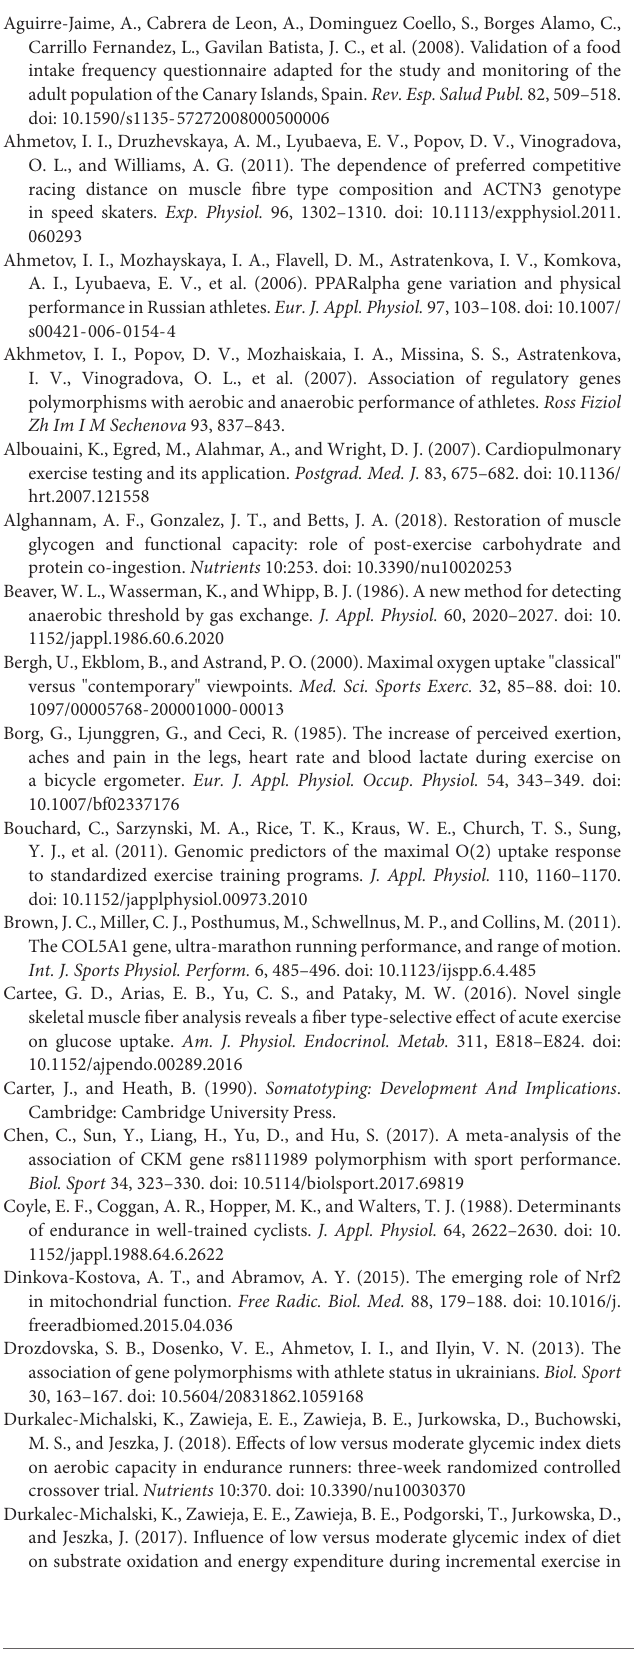
endurance athletes: a randomized counterbalanced cross-over trial. Int. J. Food Sci. Nutr. 69, 741–752. doi: